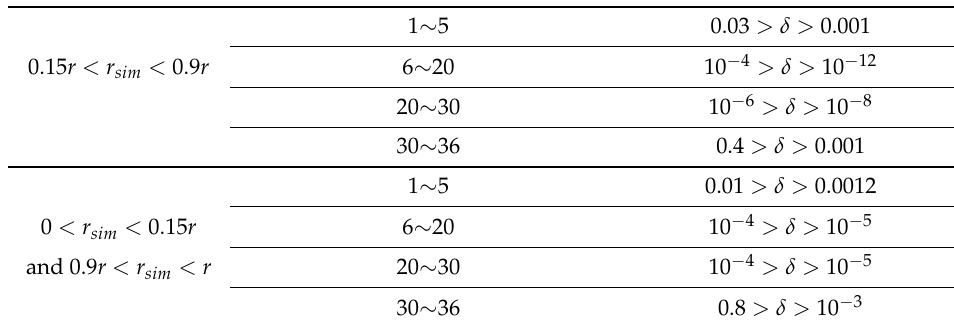
Table 2. The relationship between the relative voltage error and number and position of the simulating